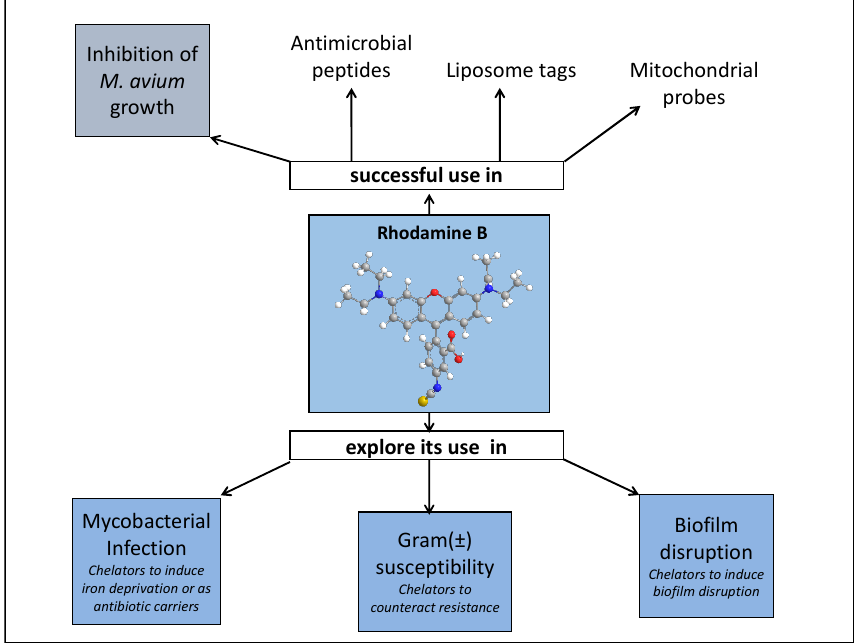
Figure 10. A graphical representation of past and future fields of application of rhodamine B conjugates.